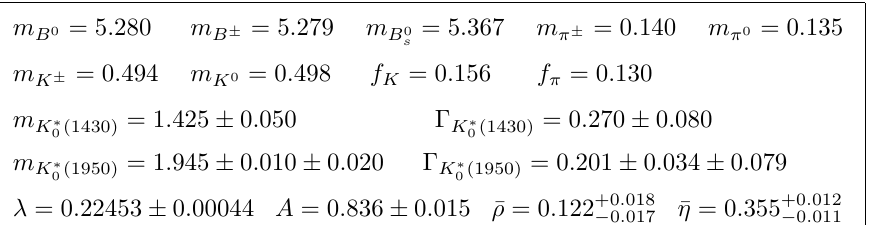
(1950) (in units of GeV) and (1430) and K (cid:3) 0 0